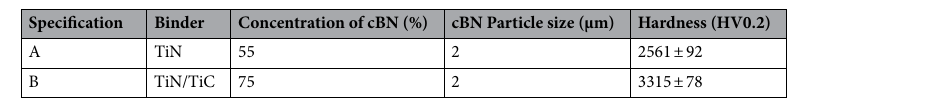
Table 2. Specification of ground PcBN workpieces.